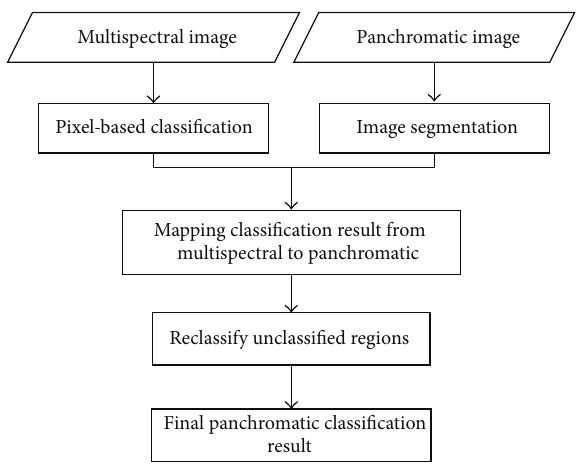
Figure 1: The flow chart of the proposed classification